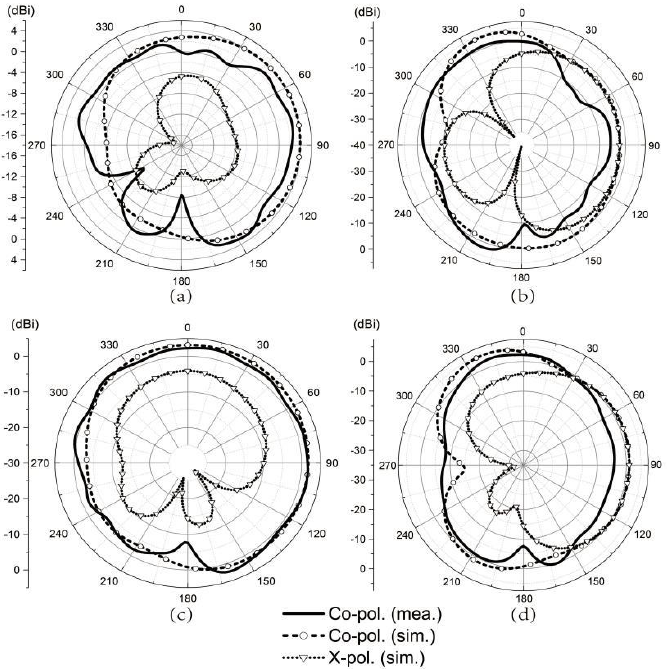
Figure 7. ( a ) Photo of the fabricated MTM-based wideband antenna. ( b ) Simulated and measured |S | and gain values. 11